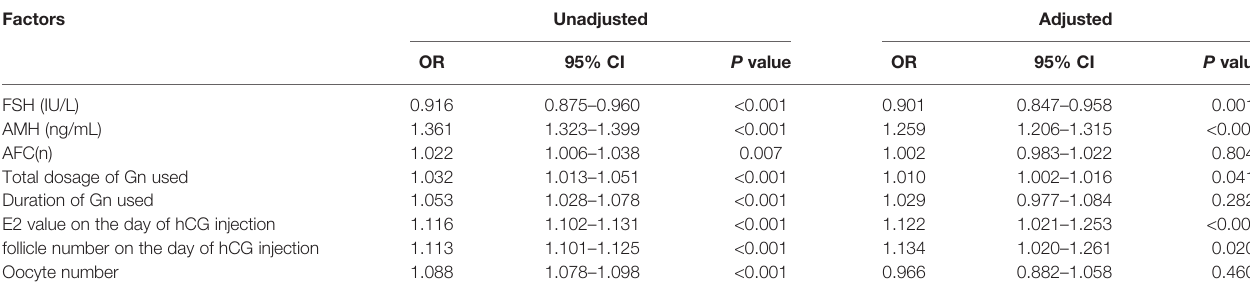
TABLE 2 | Logistic regression analysis of factors related to OHSS.